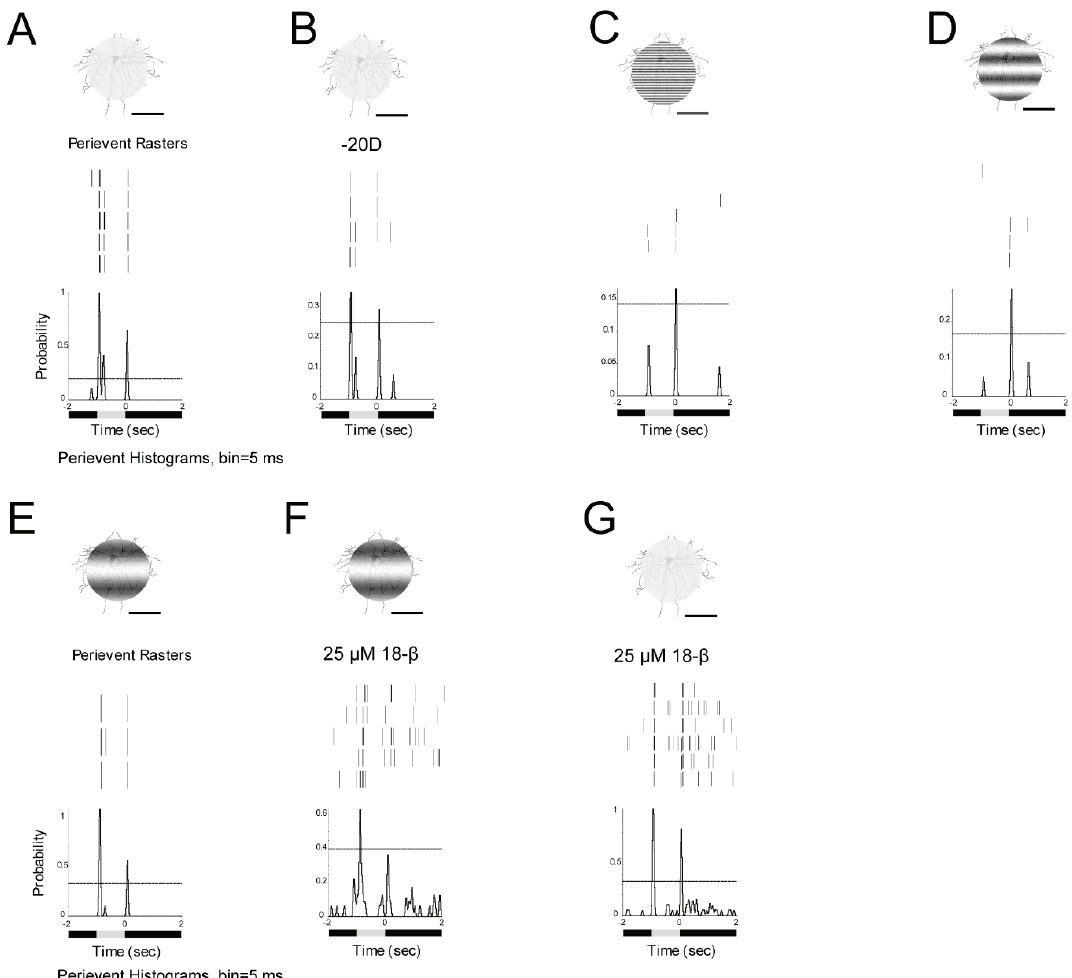
Figure 9. ON–OFF RGCs showed different responses to defocused images and spatial